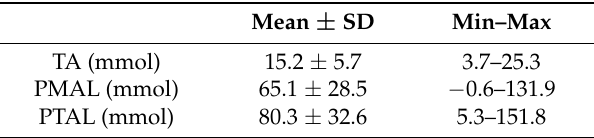
Table 4. Mean ± SD and minimum-maximum (min–max) values of the measured titratable acidity (TA), the calculated potential metabolic acid load (PMAL), and the potential total acid load (PTAL) in the compounded parenteral mixtures evaluated in this study ( n =